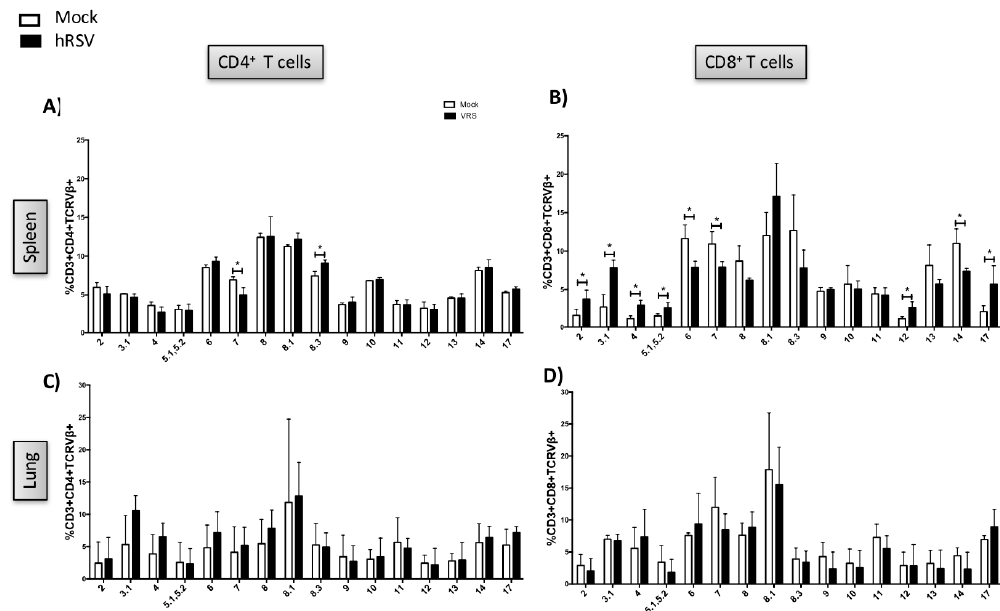
Figure 2. TCR repertoire of T cells expanded by hRSV infection. BALB / cJ mice were infected with 1 × 106 PFU of hRSV and 7 days after infection mice were euthanized. To determine the repertoire of the TCR in the lungs, purified T cells from this tissue were then cocultured with heat-inactivated hRSV-pulsed dendritic cells. The coculture was stimulated with heat-inactivated hRSV, and after the T cell expansion, the repertoire of TCRs expressed by T cells derived from the lung was evaluated by flow cytometry. The spleens of mice sacrificed at seventh day postinfection were collected, and the resulting splenocytes cells were then stimulated with heat-inactivated hRSV (HI-hRSV). The repertoire of the CD4 + ( A ) and CD8 + ( B ) in the spleen, and CD4 + ( C ) and CD8 + ( D ) in the lungs evaluated